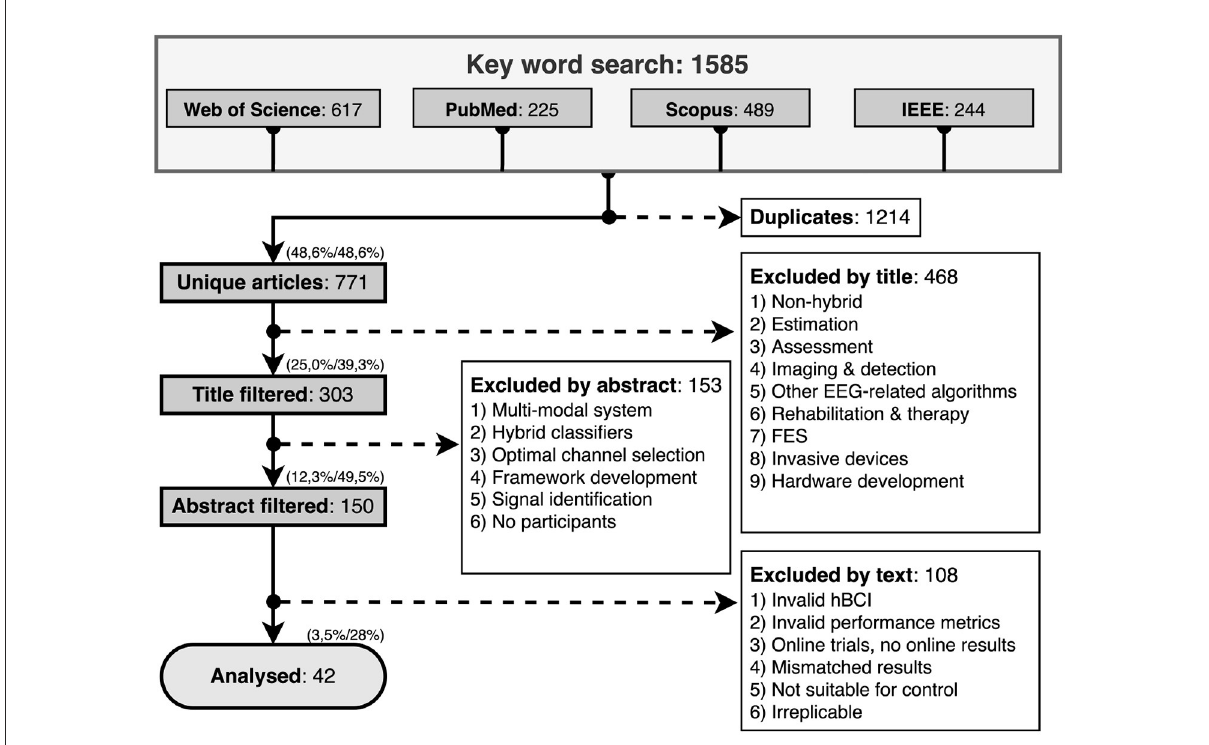
FIGURE1 Inclusion/exclusion criteria